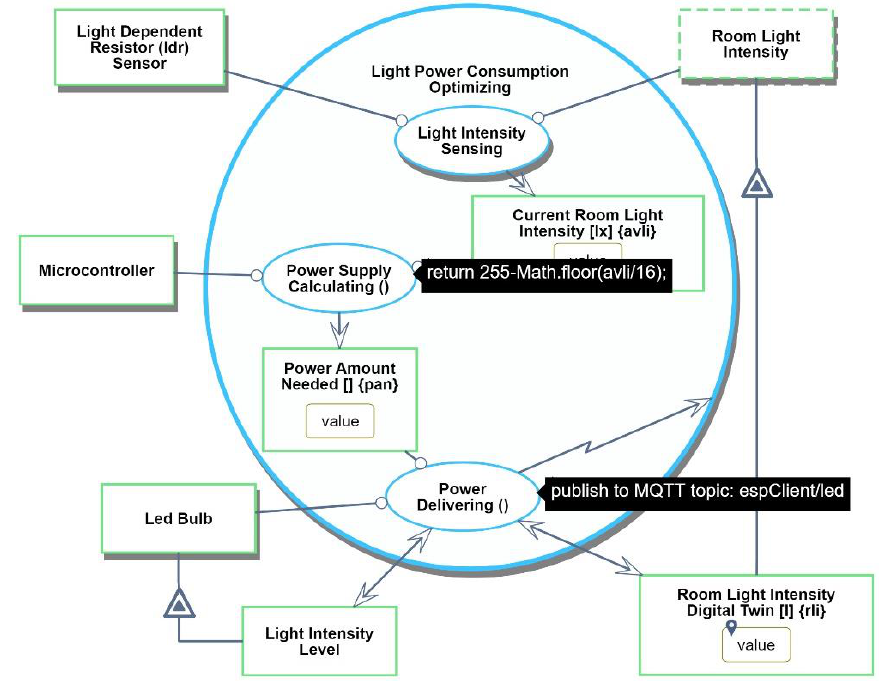
Figure 16. SD1, in which Light Power Consumption Optimizing is zoomed into.